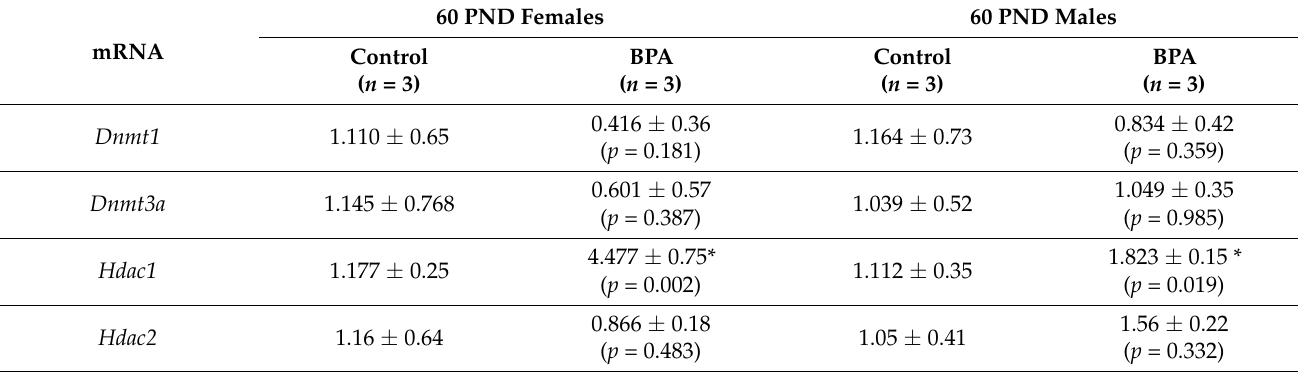
Table 4. Expression analysis of epigenetic biomarkers in weaned (60 PND) animals.